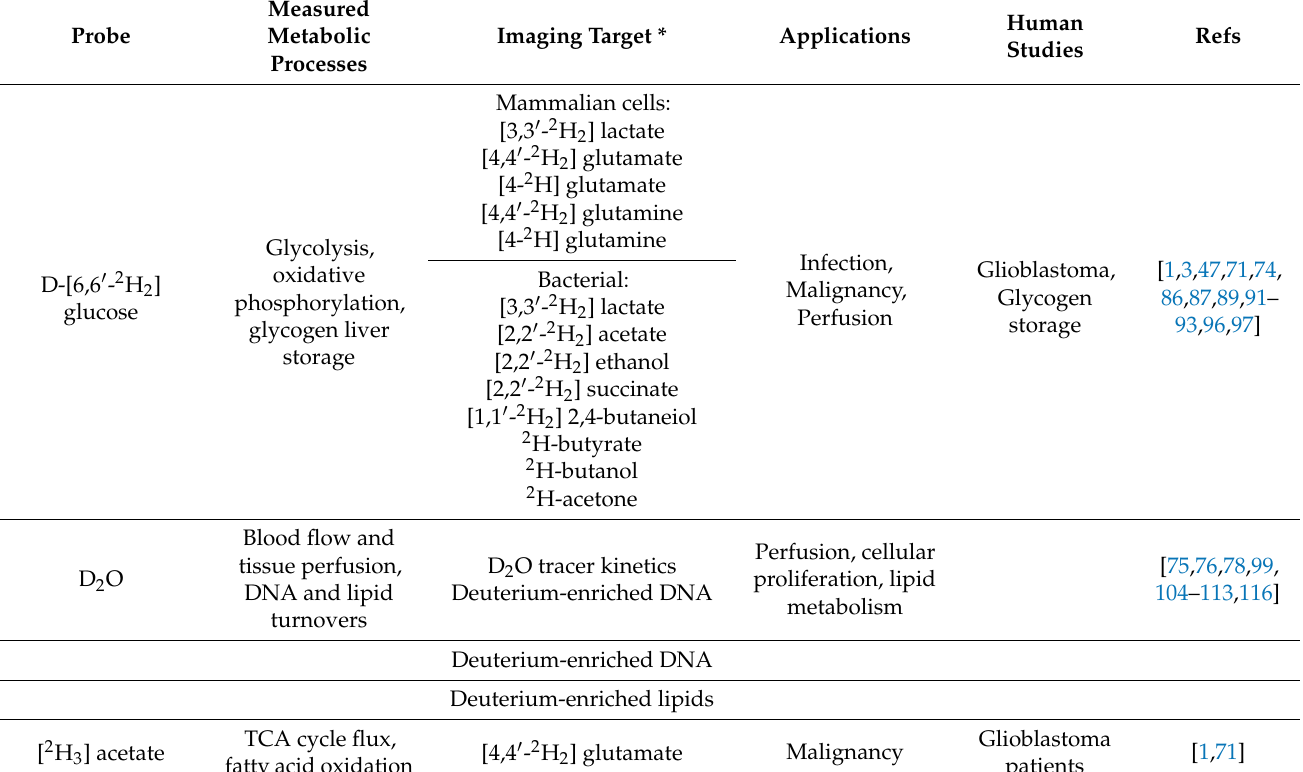
Figure 2. ( A ) The sum of 12 deuterium NMR spectra during 60 min of [2,3- 2 H 2 ] fumarate infusion to a lymphoma-bearing mice (EL4) prior to treatment with Etoposide. ( B , C ) show metabolite concentration maps of [2,3- 2 H 2 ] furmarate and [2,3- 2 H 2 ] malate prior to treatment with Etoposide in the EL4 model. Tumor locations are outlined by the white dotted lines. ( D ) The sum of 12 deuterium NMR spectra during 60 min of [2,3- 2 H 2 ] furmarate infusion to EL4 tumor model after a treatment with Etoposide, shows production of [2,3- 2 H 2 ] malate. ( E , F ) show metabolite concentration maps of [2,3- 2 H 2 ] furmarate and [2,3- 2 H 2 ] malate 48 h after to treatment with Etoposide, displaying an increase in malate concentration. Adapted from Hesse et al. 2021 (Creative Commons Attribution License 4.0, CC BY). Table 1. Deuterium MRS/DMI studies in living